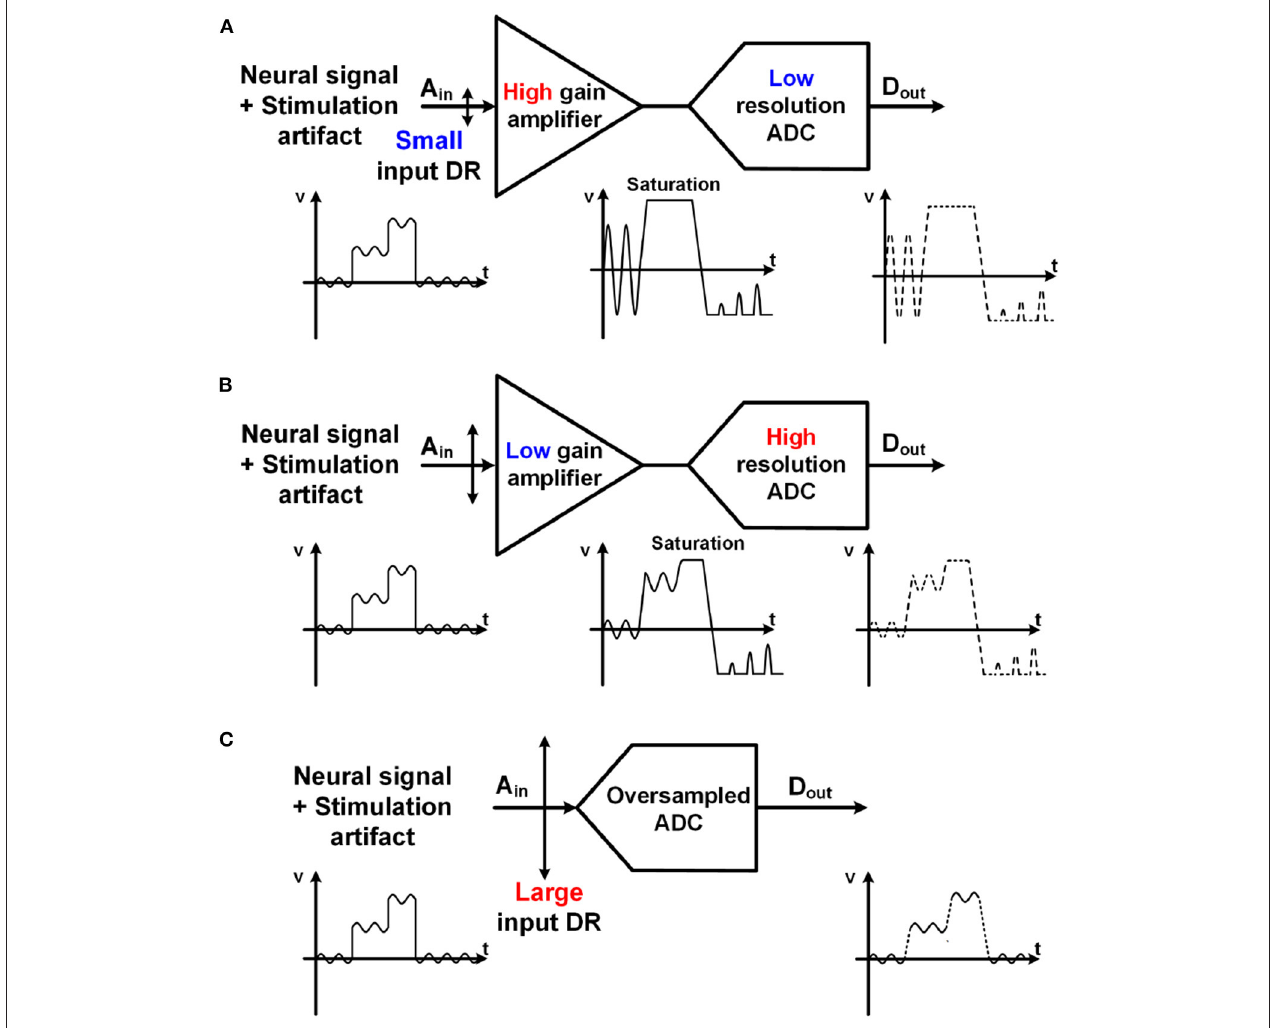
FIGURE 8 | Comparison with various structures for neural recording with stimulation artifact. Both (A) a high gain amplifier with a lower resolution ADC and (B) a lower gain amplifier with a higher resolution ADC have potential for saturation due to large stimulation artifact. (C) Unity gain ADC-direct front-end structure using an oversampling ADC maximizes its input